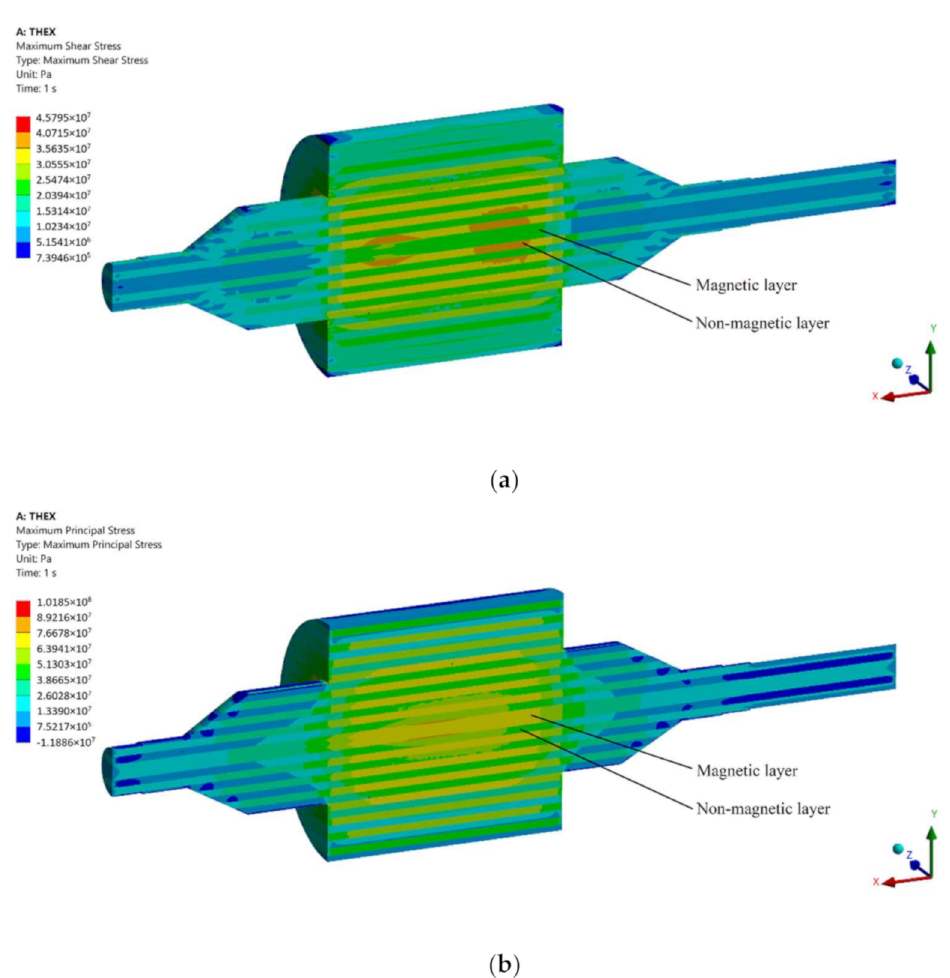
Figure 11. Stress distributions of laminated rotor structure under centrifugal and thermal loads.